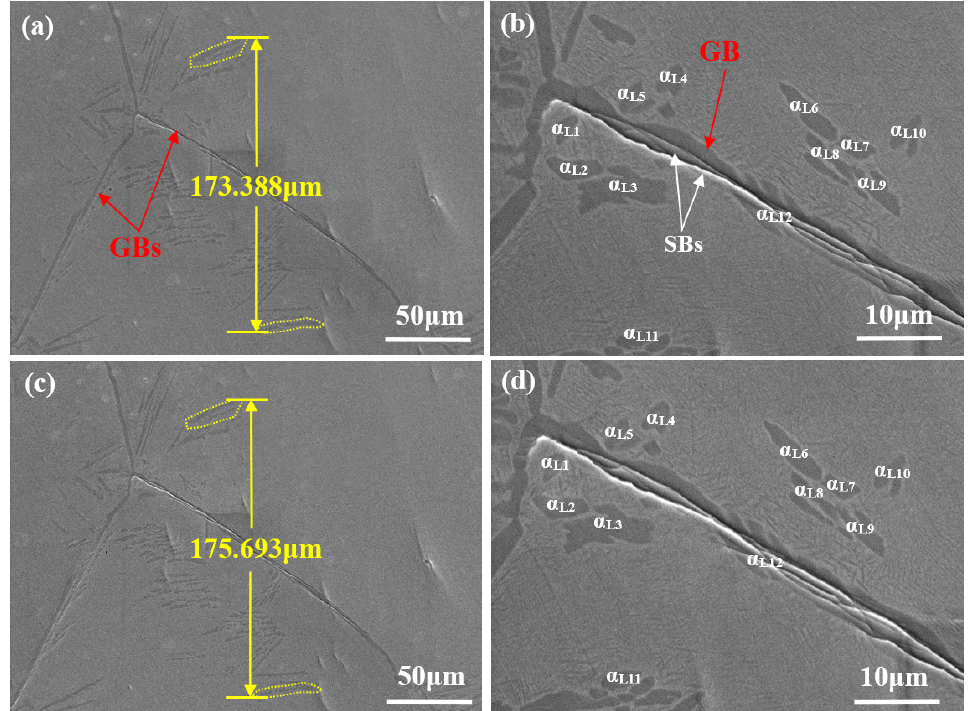
Figure 12. In situ SEM images of the lamellar microstructure; ( a ) a selected area at position A’; ( b ) magnified image showing the morphologies of α L phase at position A’; ( c ) the area in ( a ) stretched to position B’; ( d ) magnified image illustrating the deformation within α L phase at position B’.